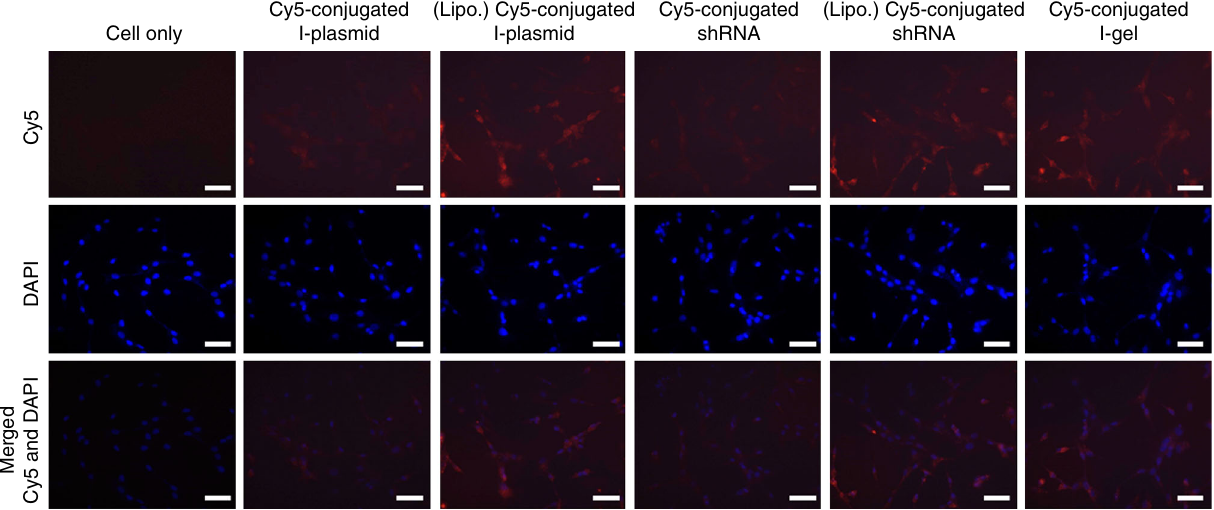
Fig. 4 Comparison of intracellular uptake of plasmids in different formats. Second from left: I-plasmid labeled with Cy5, third: I-plasmid labeled with Cy5 complexed with lipofectamine, fourth: shRNA labeled with Cy5, fi fth: shRNA labeled with Cy5 complexed with lipofectamine and the last: I-gel labeled with Cy5. Scale bar: 20 μ